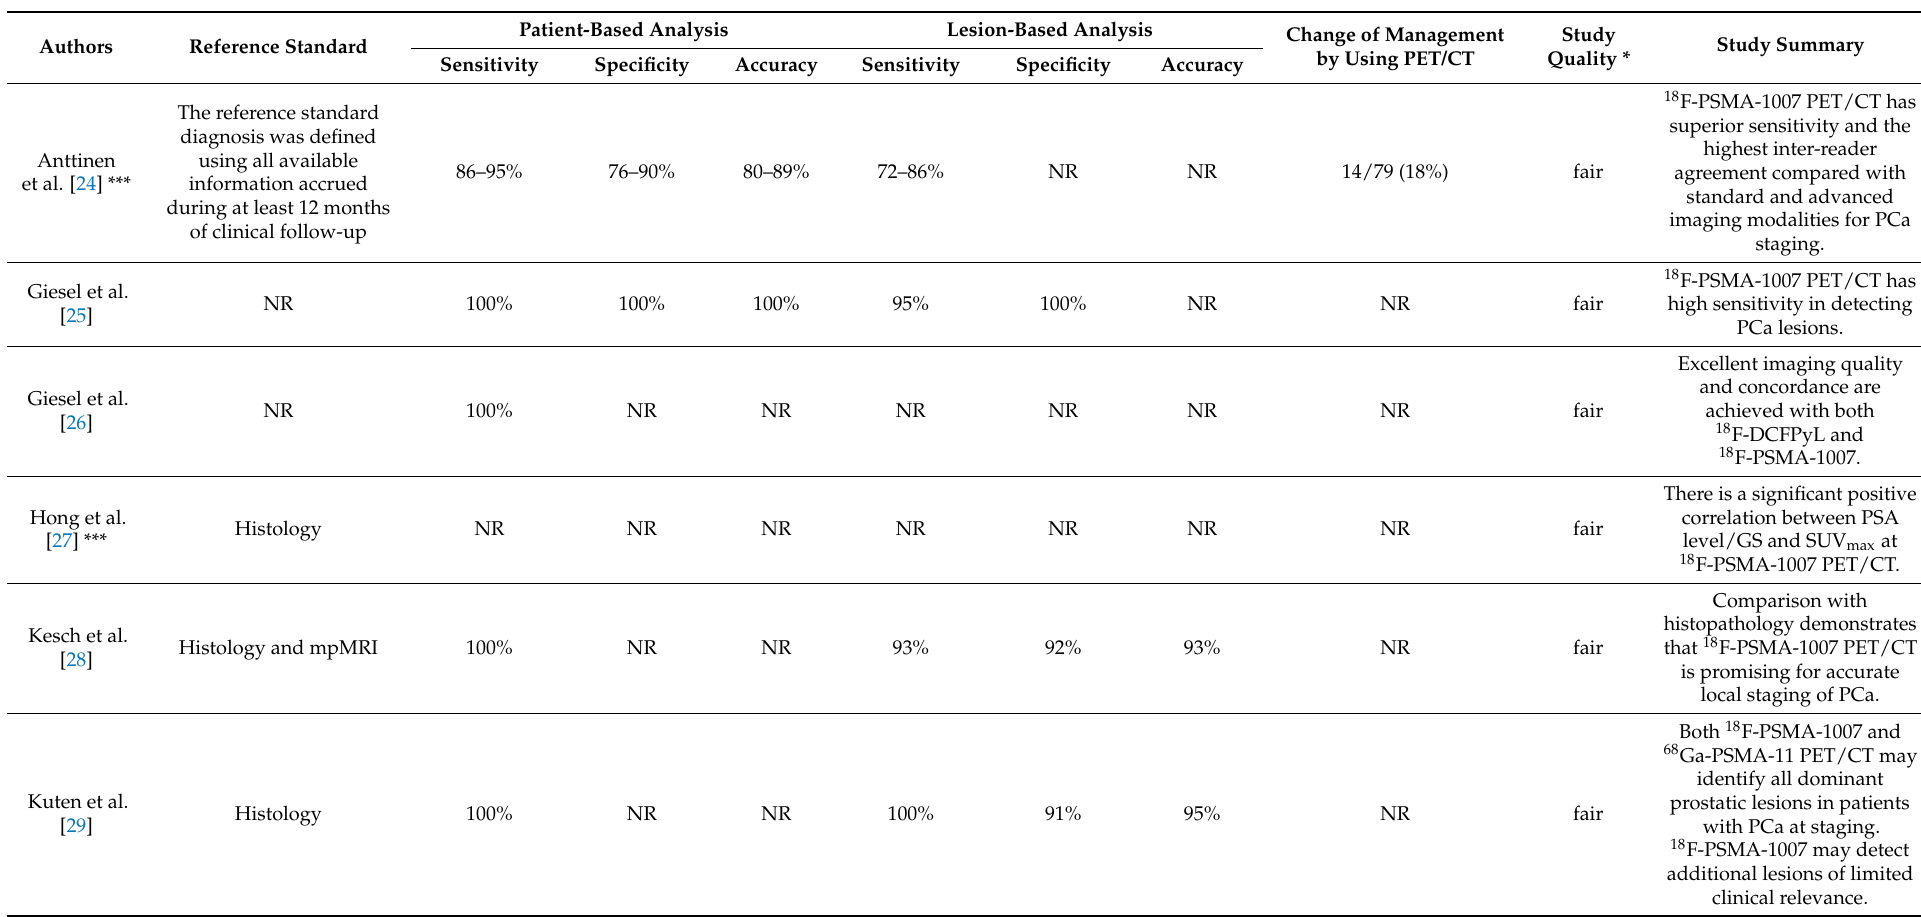
Table 3. Main findings of the included studies about 18 F-PSMA-1007 PET/CT in staging patients with prostate